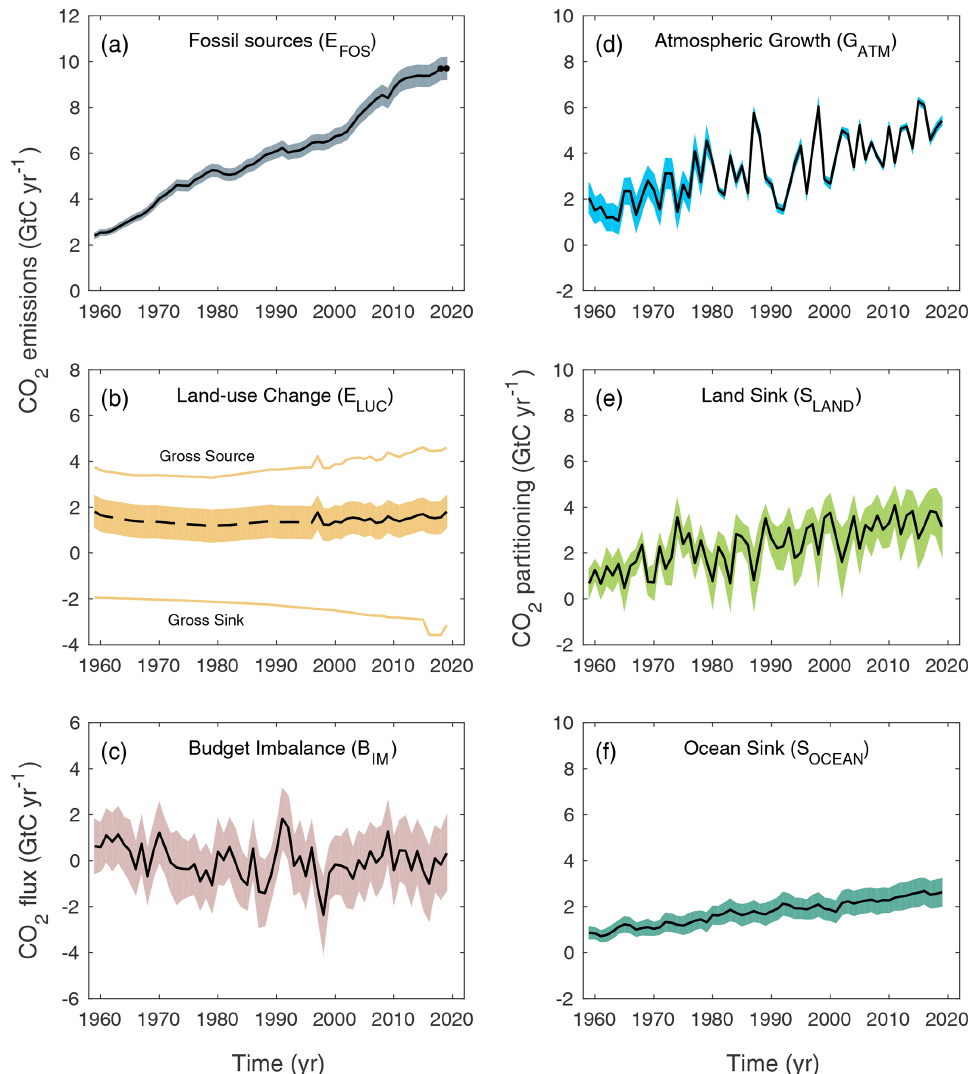
Figure 4. Components of the global carbon budget and their uncertainties as a function of time, presented individually for (a) fossil CO 2 emissions including cement carbonation sink ( E FOS ), (b) emissions from land-use change ( E LUC ), (c) the budget imbalance that is not accounted for by the other terms, (d) growth rate in atmospheric CO 2 concentration ( G ATM ), (e) the land CO 2 sink ( S LAND , positive indicates a flux from the atmosphere to the land), and (f) the ocean CO 2 sink ( S OCEAN , positive indicates a flux from the atmosphere to the ocean). All time series are inGtCyr − 1 with the uncertainty bounds representing ± 1 σ in shaded colour. Data sources are as in Fig. 3. The black dots in (a) show values for 2018–2019 that originate from a different data set to the remainder of the data (see text). The dashed line in (b) identifies the pre-satellite period before the inclusion of emissions from peatland